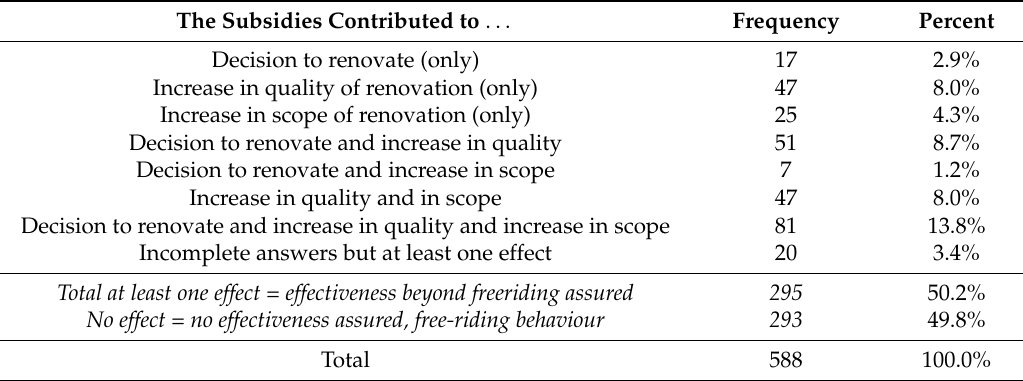
Table 2. Description of the variables informing about the effectiveness of subsidies. The Subsidies Contributed to . .